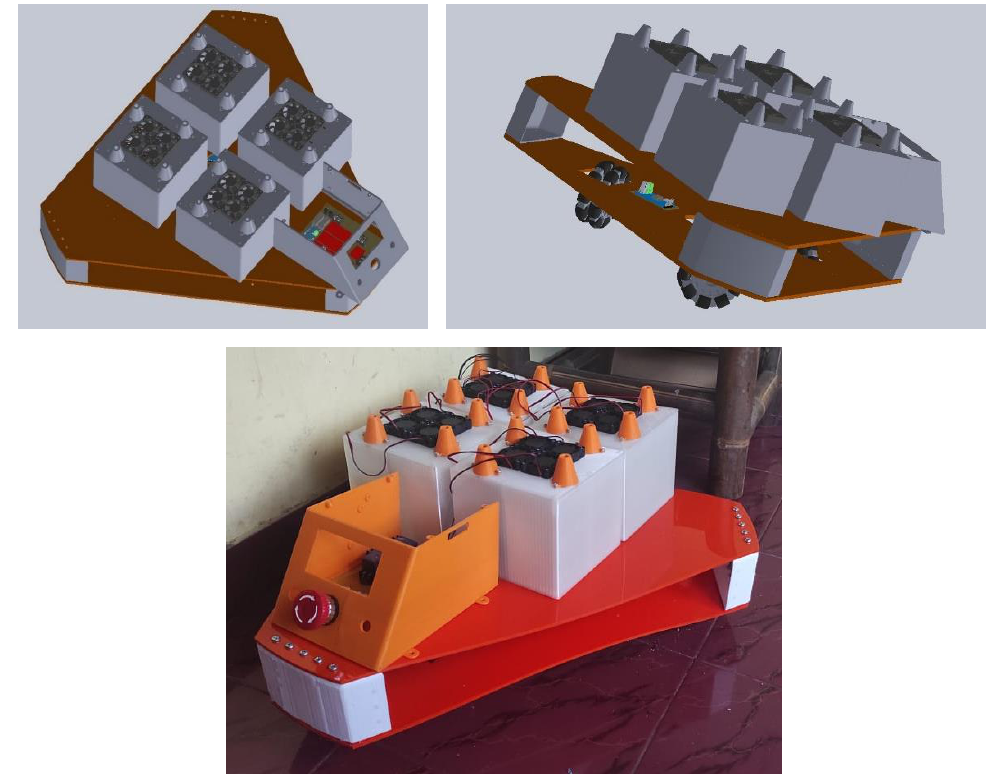
Figure 10. Four-wheel Omnidirectional